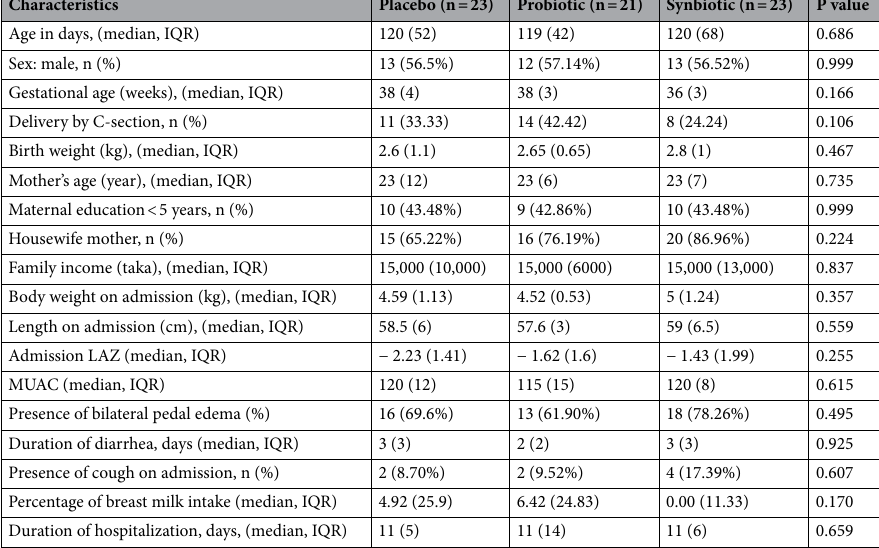
Characteristics